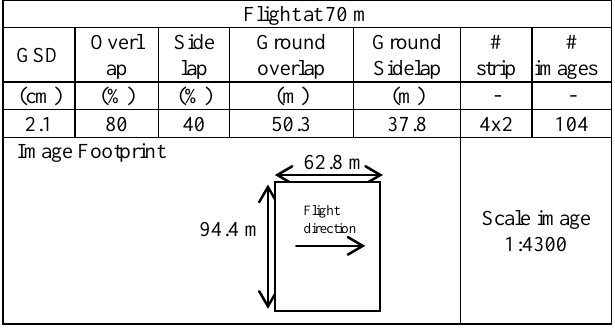
Table 3 – UAS flight plan characteristics at 70